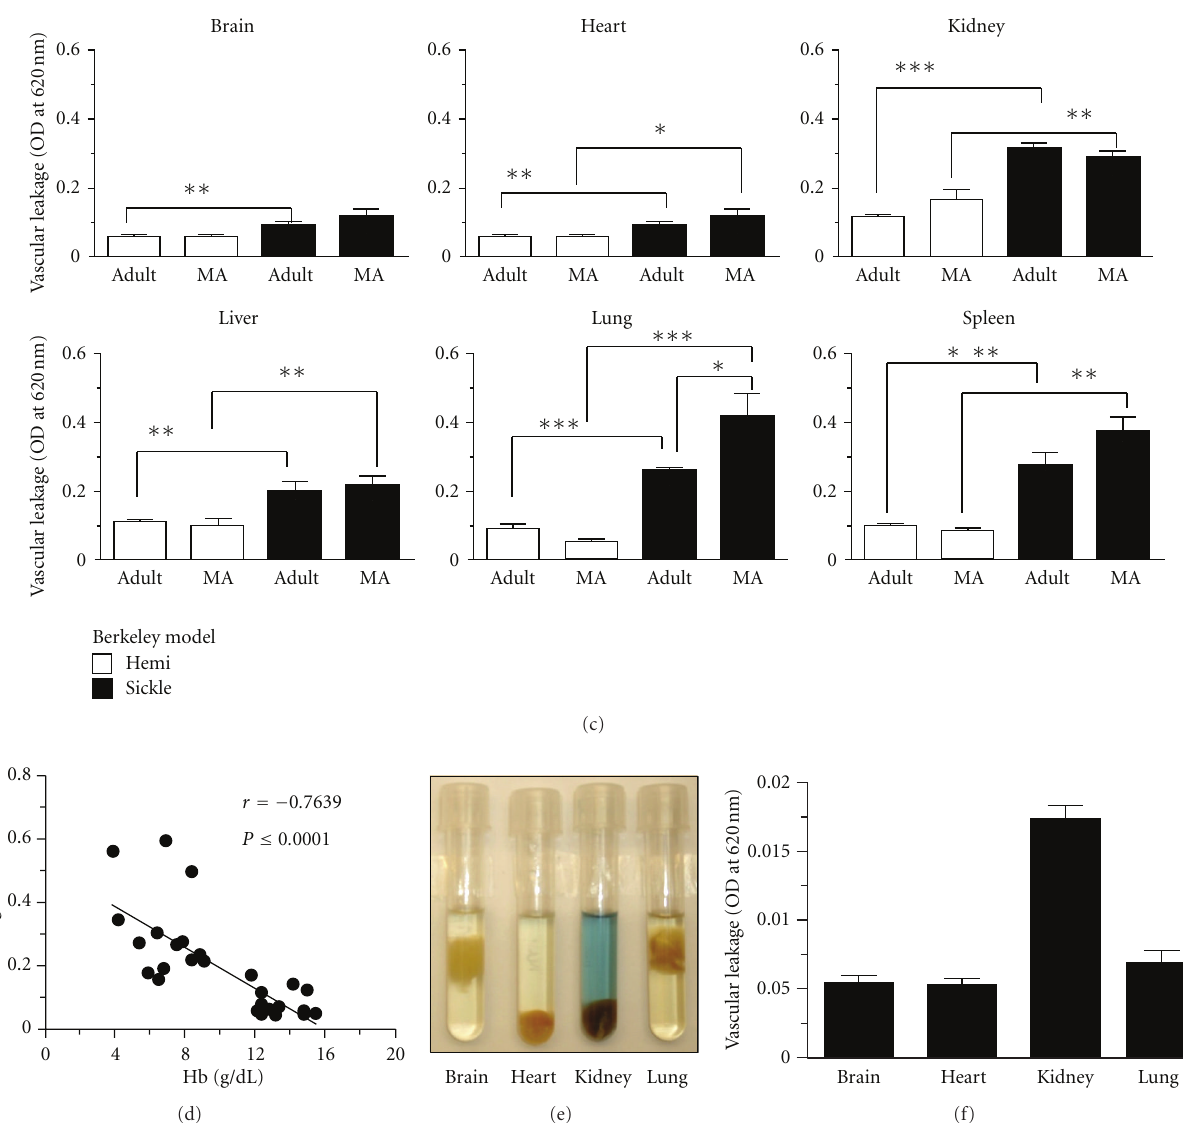
Figure 1: Vascular barrier dysfunction in sickle mice. (a) Representative images of organs isolated from sickle mice after injection with Evans blue dye and incubation in formamide for three days. (b, c) Vascular leakage in the indicated organs in adult (3–6 months) and middle-aged (10–13 months) mice of the Townes (heterozygotes-HbAS ( h β A / h β S ) and homozygote sickle-HbSS ( h β S / h β S )) and Berkeley (hemizygotes and sickle) models. The number of mice studied was as follows: Townes: n = 3 for each genotype and age group; Berkeley: Sickle adult, n = 9; sickle middle-aged n = 6; hemizygote adult, n = 10, hemizygote middle-aged n = 5. (d) Vascular leakage correlates with hemoglobin. Data shown is the vascular leakage in the lung for a total of 30 mice (15 sickle and 15 hemizygotes) of the Berkeley model. (e) Typical images for the indicated organs isolated from young (4–6 weeks old) Berkeley mice injected with Evans blue dye and incubated in formamide for 3 days. (f) Histogram showing the quantification of Evans blue extravasation of major organs in young sickle mice ( n = 4). ∗ P < 0 . 05, ∗∗ P < 0 . 01, and ∗∗∗ P < 0 .